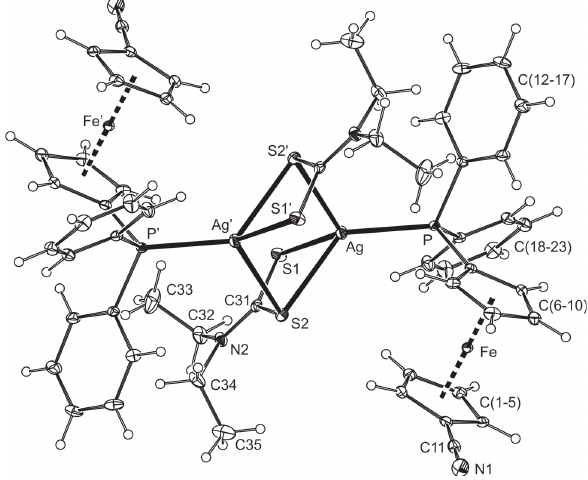
Table 1: Data collection and